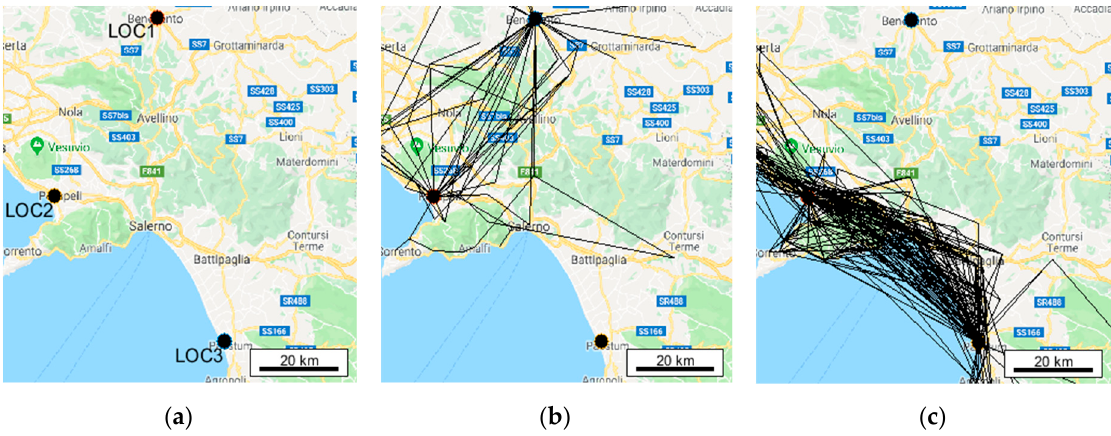
Figure 1. Locations having comparable distances LOC1–LOC2 and LOC2–LOC3 ( a ), with trajectories passing through LOC1 and LOC2 ( b ), and LOC2 and LOC3 ( c ), within a maximum time period of six hours.